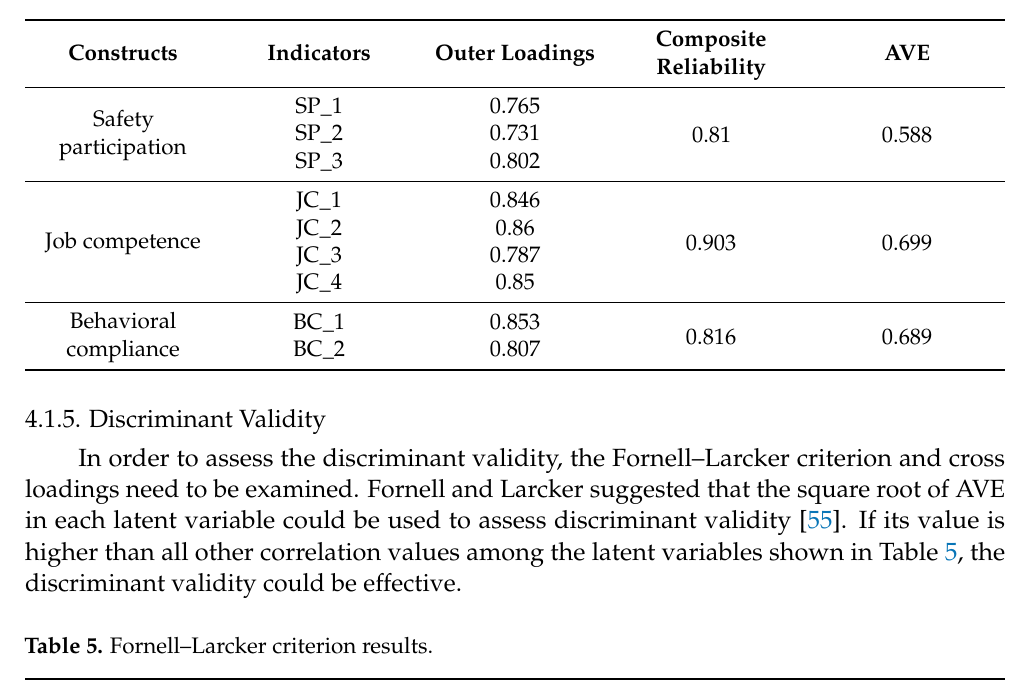
Table 4. Measurement model results.